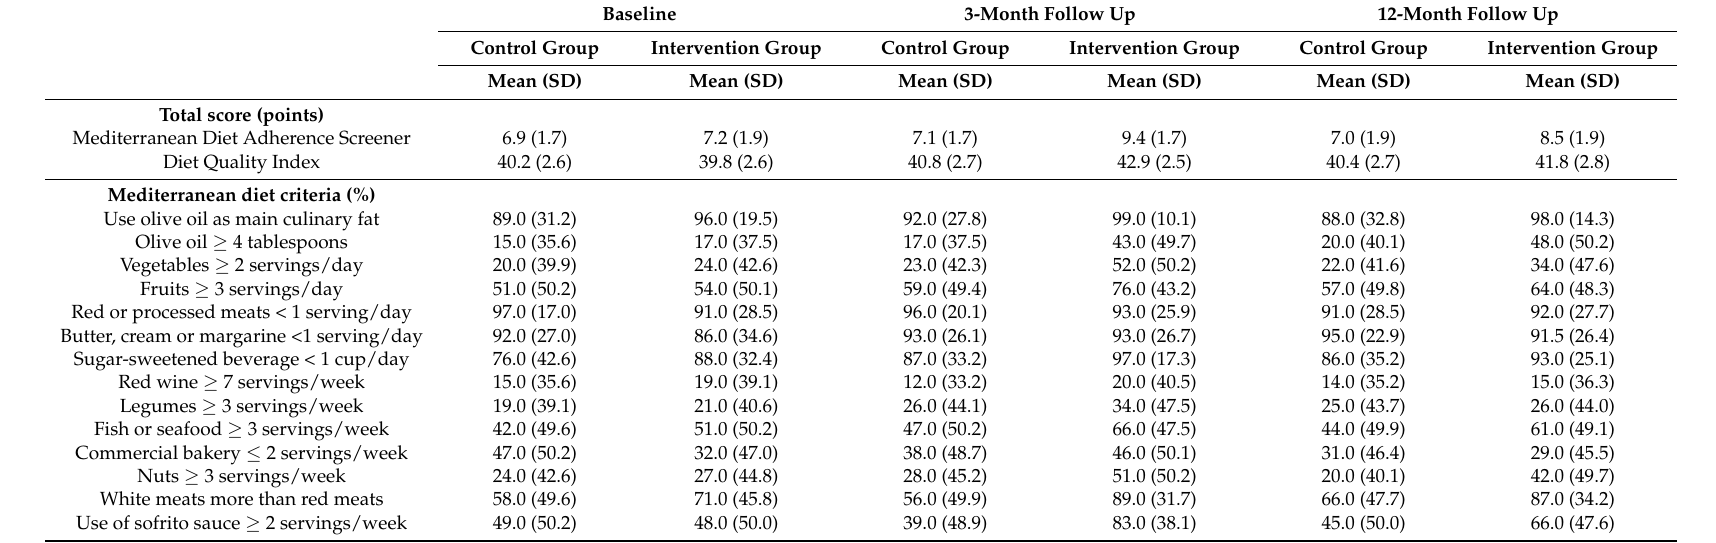
Table 2. Adherence to the Mediterranean diet and diet quality throughout the